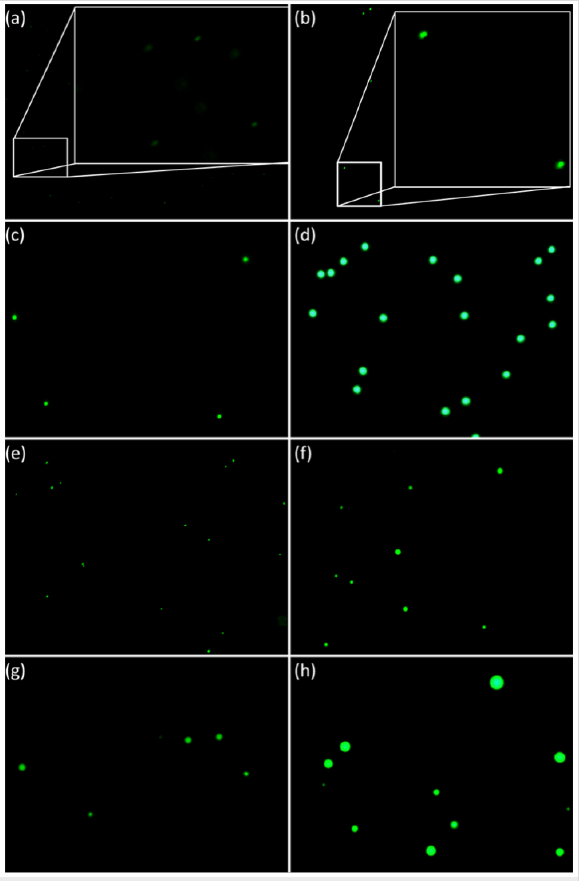
Figure 3: Fluorescence microscopy images of labelled particles. Microbead standards at similar exposure times are shown in (a)–(d); (a) 190 nm, inset is a 4× enlargement of selected area, (b) 520 nm, inset is a 4× enlargement of selected area, (c) 1020 nm and (d) 1900 nm. Aggregates formed after ca. 60 min incubation of Alexa 488 labelled galectin-3 (A488gal-3) with lactose-functionalized dendrimers are shown in (e)–(h); (e) A488gal-3 and 2 ; (f) A488gal-3 and 3 ; (g) A488gal-3 and 4 ; (h) A488gal-3 and 5 . Exposure times